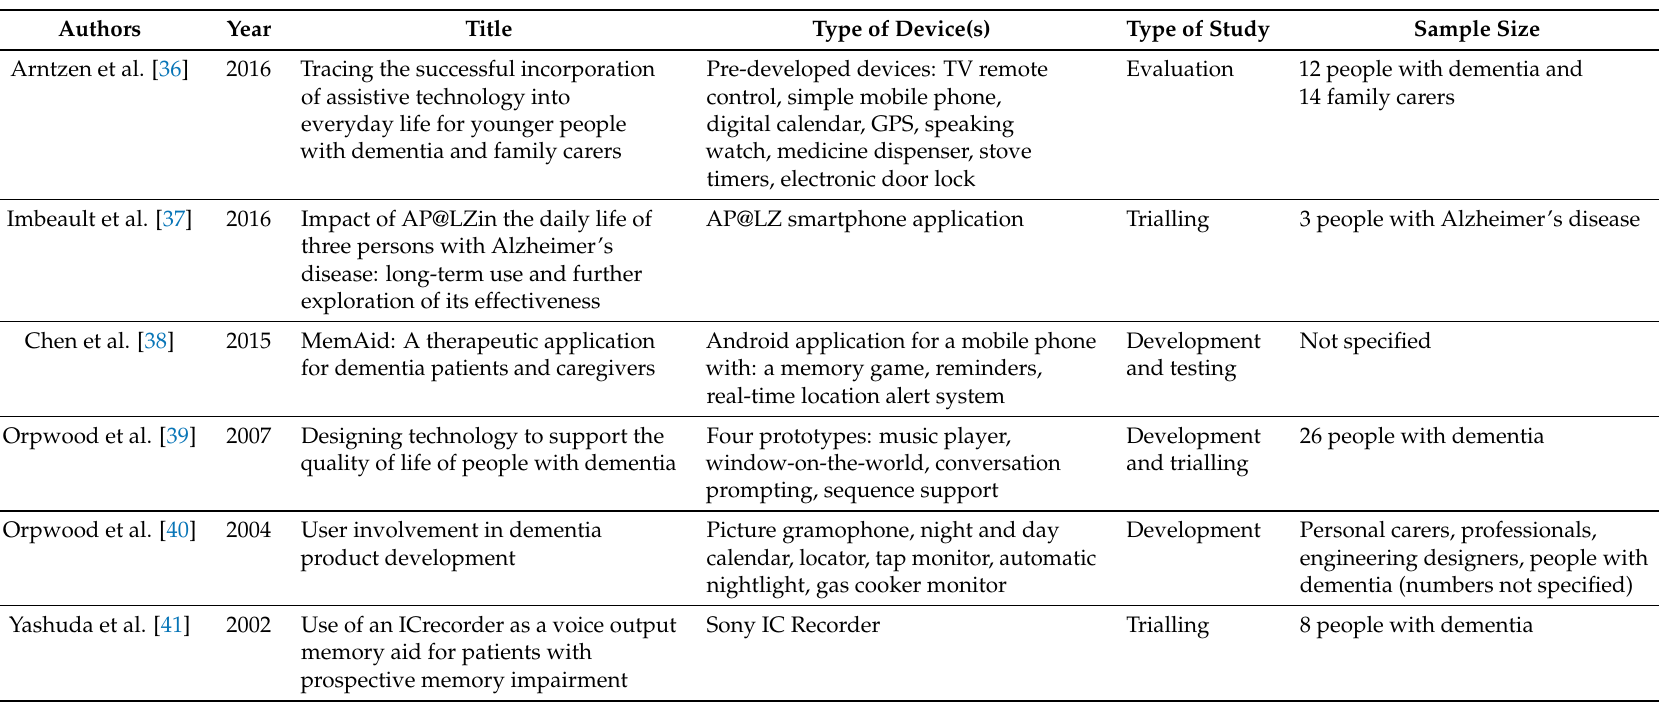
Table 1. Projects reported in the scientific literature regarding dementia and sound as a stimulus for